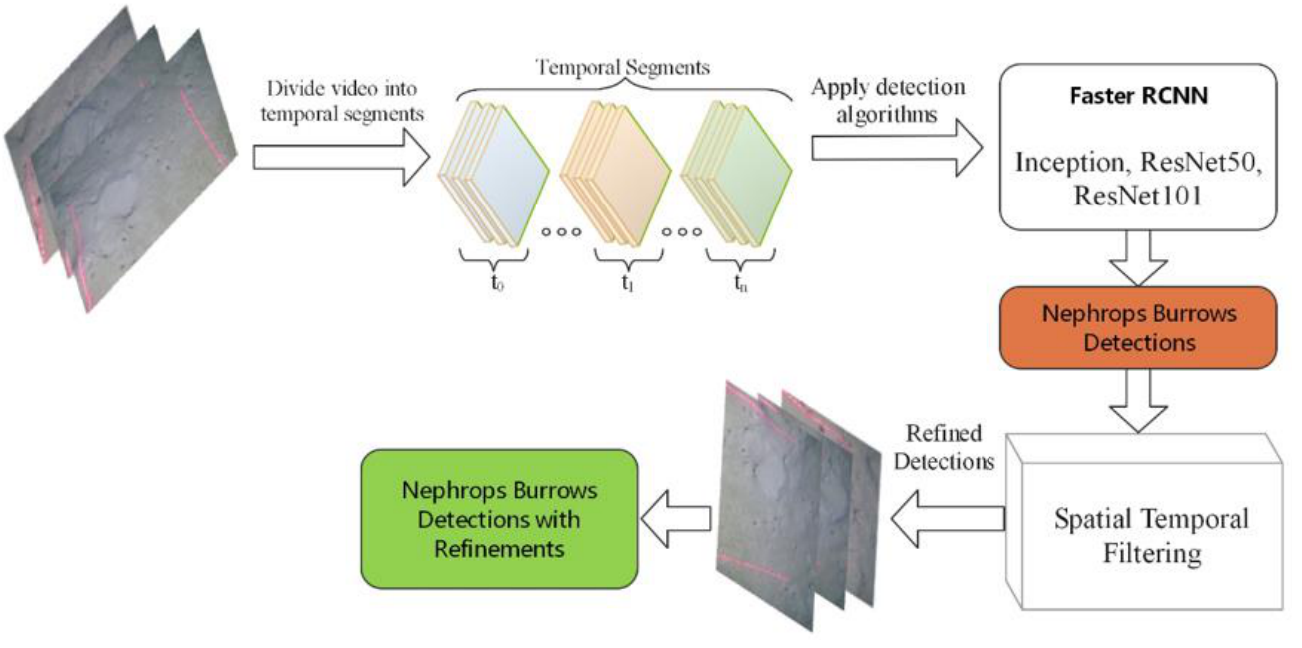
Figure 4. Detection refinement framework based on spatial – temporal filtering.